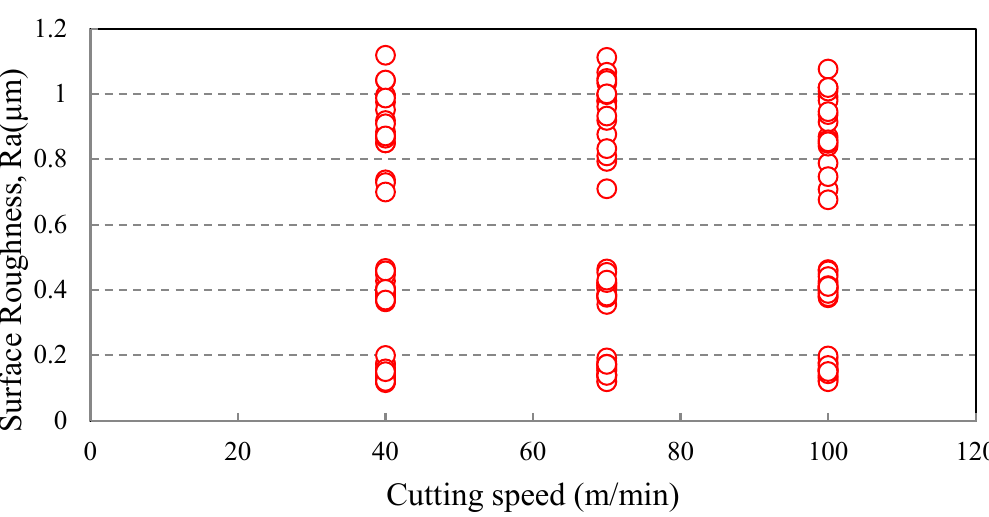
Figure 14. Roughness distribution graph in terms of cutting speed.